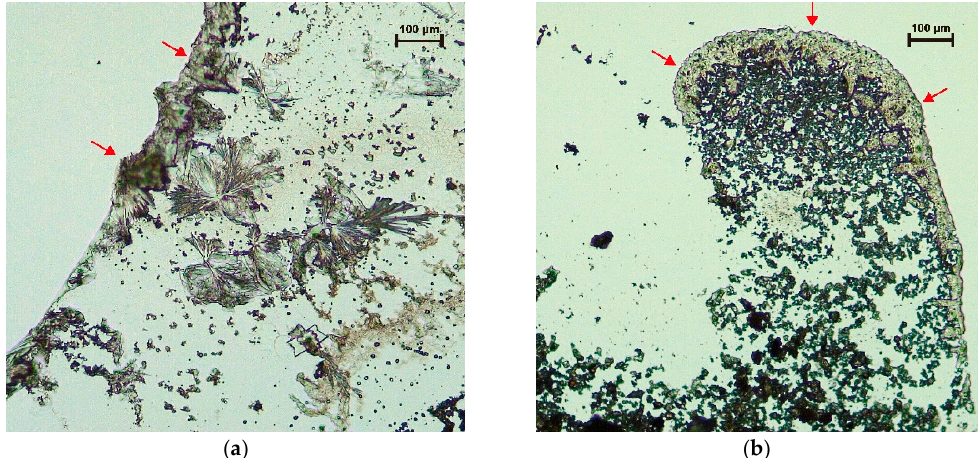
Figure 14. Reaction products of calcium-based stabilizer (the red arrows pointing); ( a ) reaction time of 0.5 h; ( b ) reaction time of 2 h.